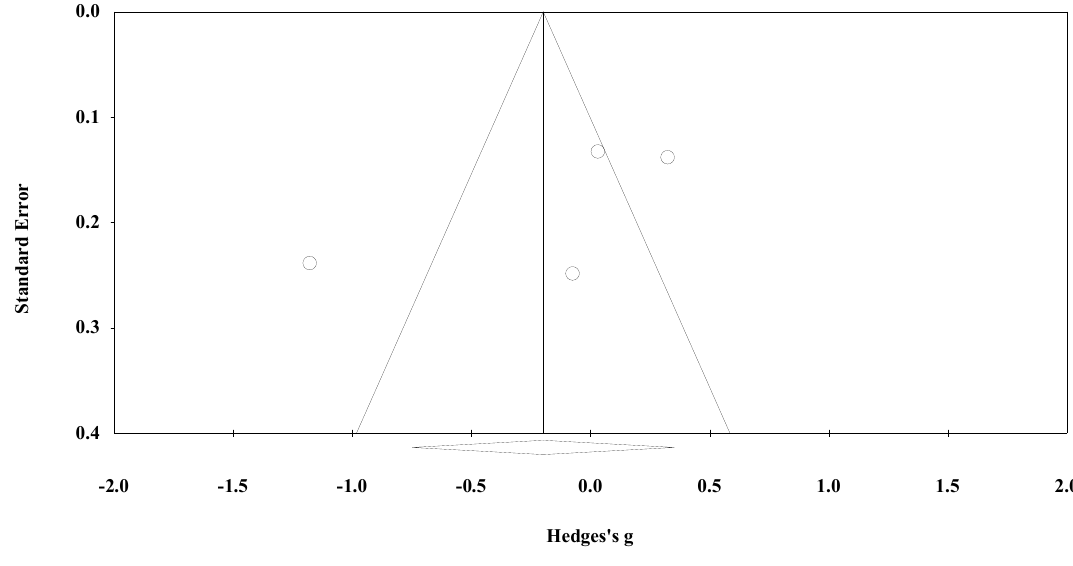
Funnel Plot for the Random Effect Model (Face-to-face vs. Synchronous) for the Cognitive